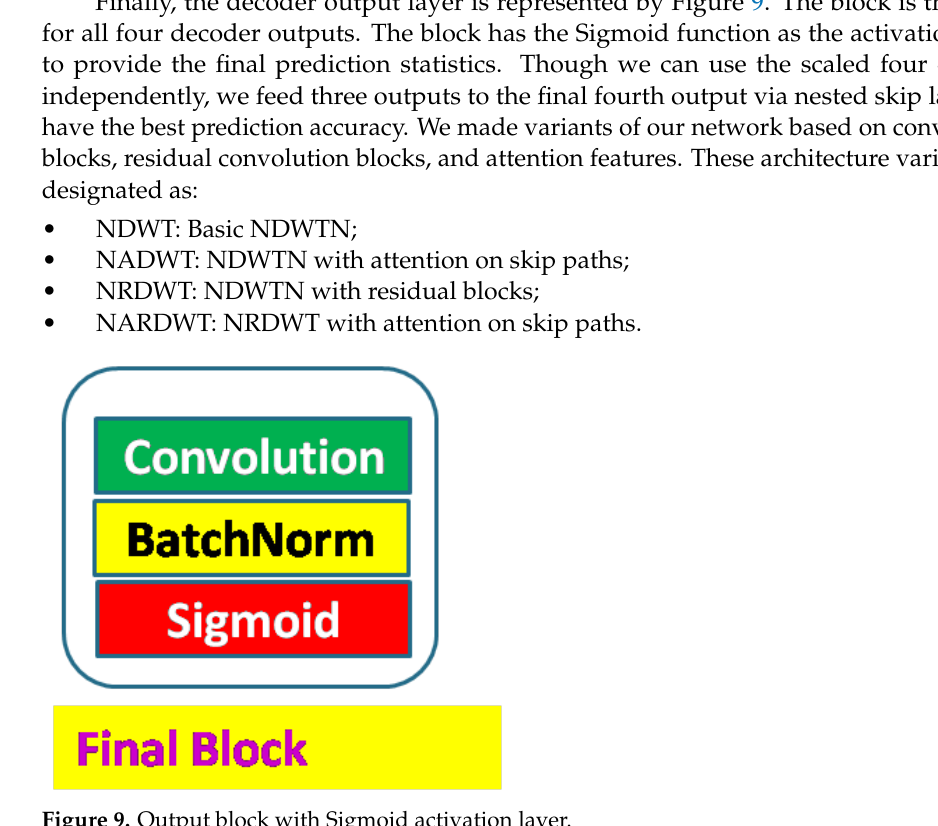
Figure 9. Output block with Sigmoid activation layer.